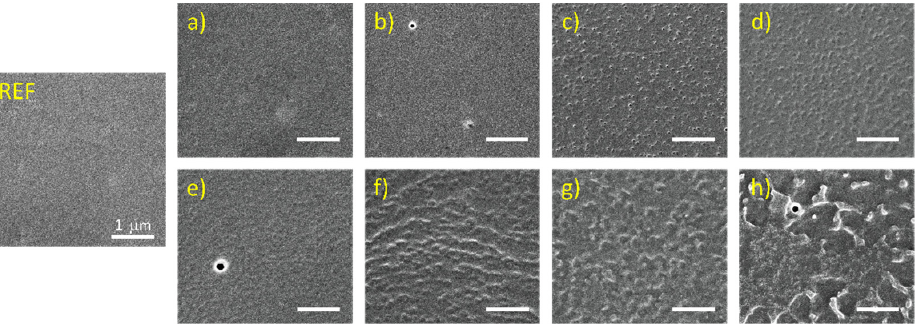
Figure 2. SEM images of BOPP foil treated by plasma at the different experimental conditions: ( a – d ) DCSBD at 1 s, 3 s, 5 s, and 10 s and ( e – h ) VDBD at 1 s, 3 s, 5 s, and 10 s.